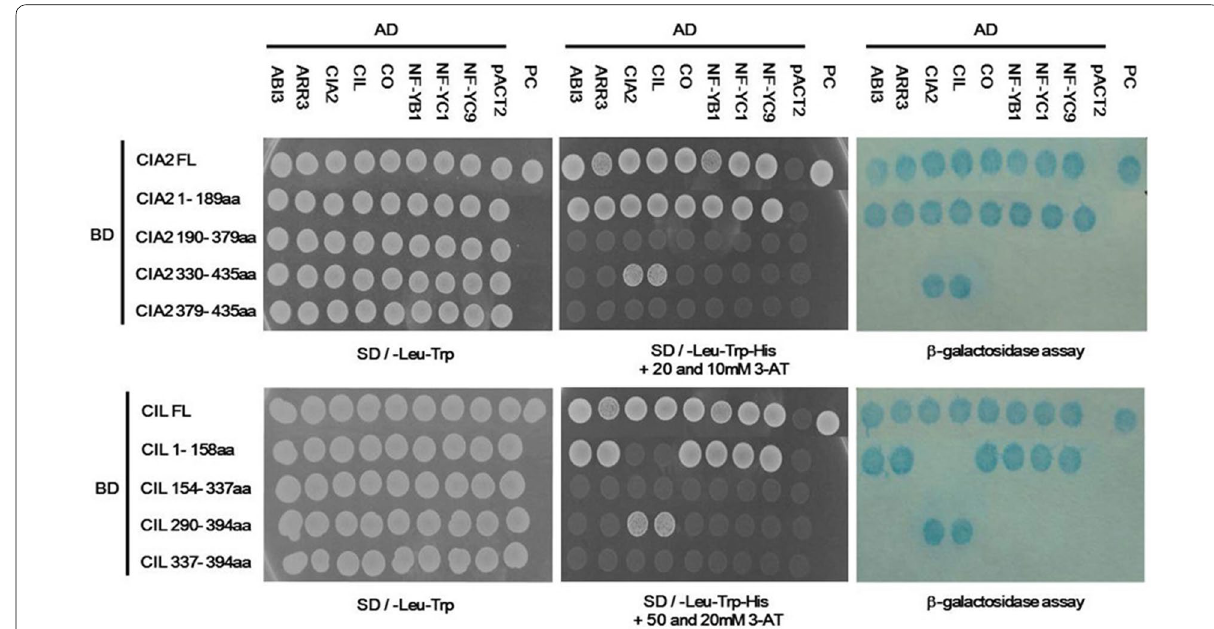
Fig. 2 Interactions among CIA2 and CIL fragments and various proteins, as revealed by Y2H assay. Vectors pAS2‑1 and pACT2 harbor GAL4 BD and GAL4 AD, respectively. The CIA2 and CIL fragments were ligated into pAS2‑1 vector. Eight full‑length CIA2‑interacting protein candidates were ligated into pACT2 vector. Colonies were assayed for SD/‑Leu‑Trp autotrophy, SD/‑Leu‑Trp‑Trp activity. pACT2, negative control. PC, positive control containing pVA3‑1 and pTD1‑1